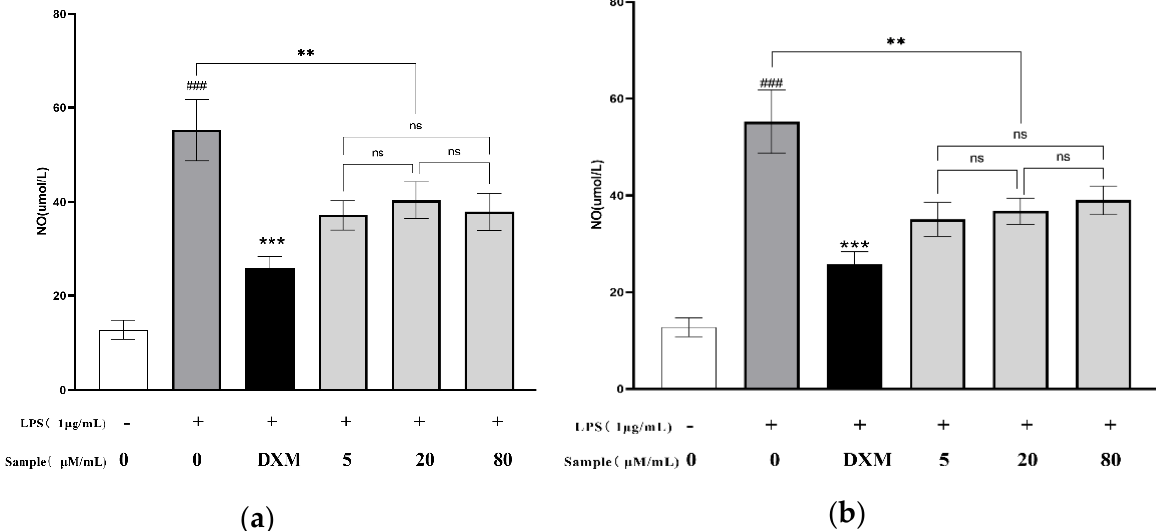
Figure 5. Ardisicreolides A ( a ) and B ( b ) decreased NO production. Dexamethasone with 1 µ g/mL was used as the positive control. The data were expressed as the mean ± SD ( n = 3). ns > 0.05, ** p < 0.01, *** p < 0.001 versus the model cells that were treated by LPS. ### p < 0.001 versus the control.